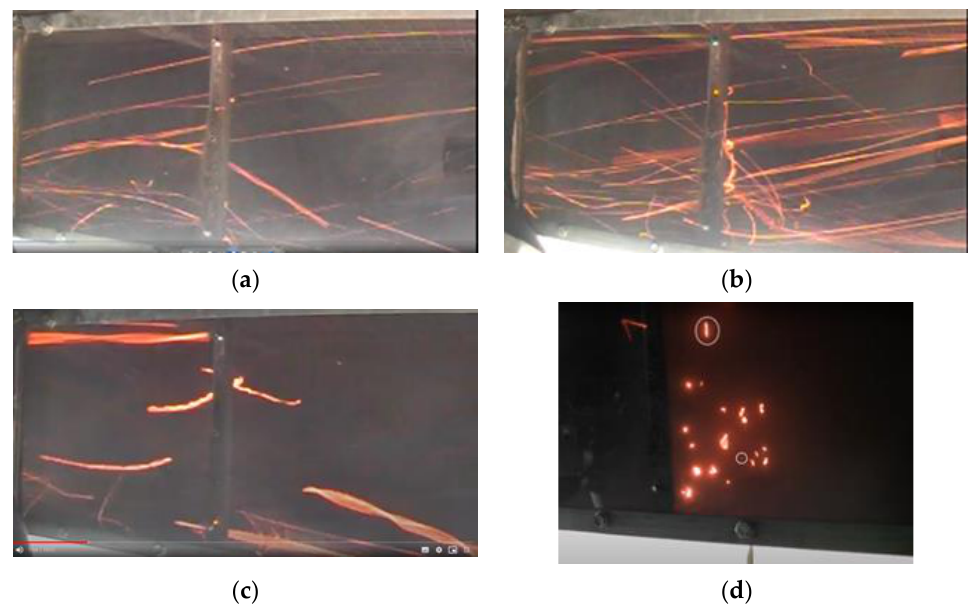
Figure 6. Firebrand shower in the wind tunnel ( a ) low intensity when no mesh was used, ( b ) high intensity when no mesh was used, ( c ) low intensity when no mesh was used, and ( d ) a typical size and shape of firebrands when the mesh was used.